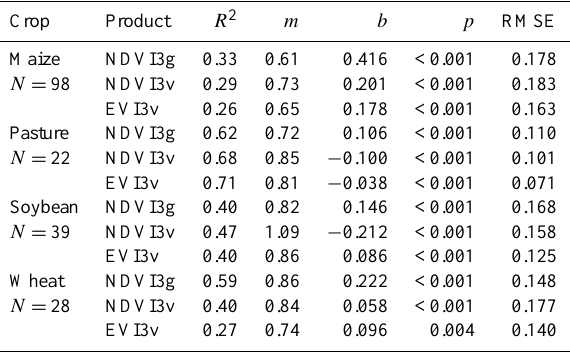
Table 1. Summary statistics ( R 2 is coefficient of determination, m is slope, b is intercept, p is significance, and RMSE is root mean square error) of the linear relationships between the frac- tion of photosynthetically active radiation intercepted by the canopy ( F PAR ) estimated by Landsat Thematic Mapper or Enhanced The- matic Mapper Plus and F PAR estimated by the long-term vegetation records (NDVI3g is Global Inventory Modeling and Mapping Stud- ies normalized difference vegetation index version 3, NDVI3v is Vegetation Index and Phenology Lab version 3 normalized differ- ence vegetation index, and EVI3v is Vegetation Index and Phenol- ogy Lab enhanced vegetation index 2).